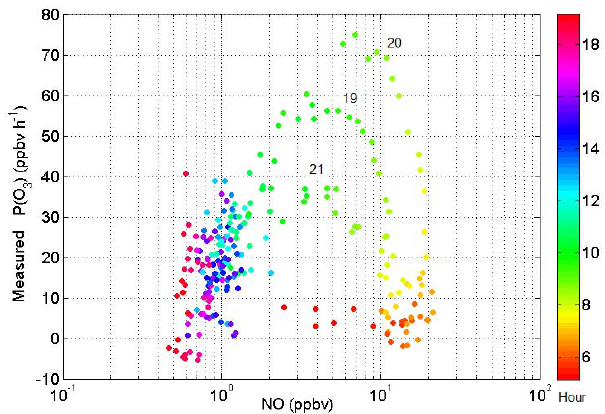
Fig. 5. Measured P (O 3 ) in NO space for the high ozone episode that started on 19 May, developed on 20 May and subsided on 21 May 2009 in Houston. The color scale corresponds to hour of the day. The number on top of every curve is the date in May.